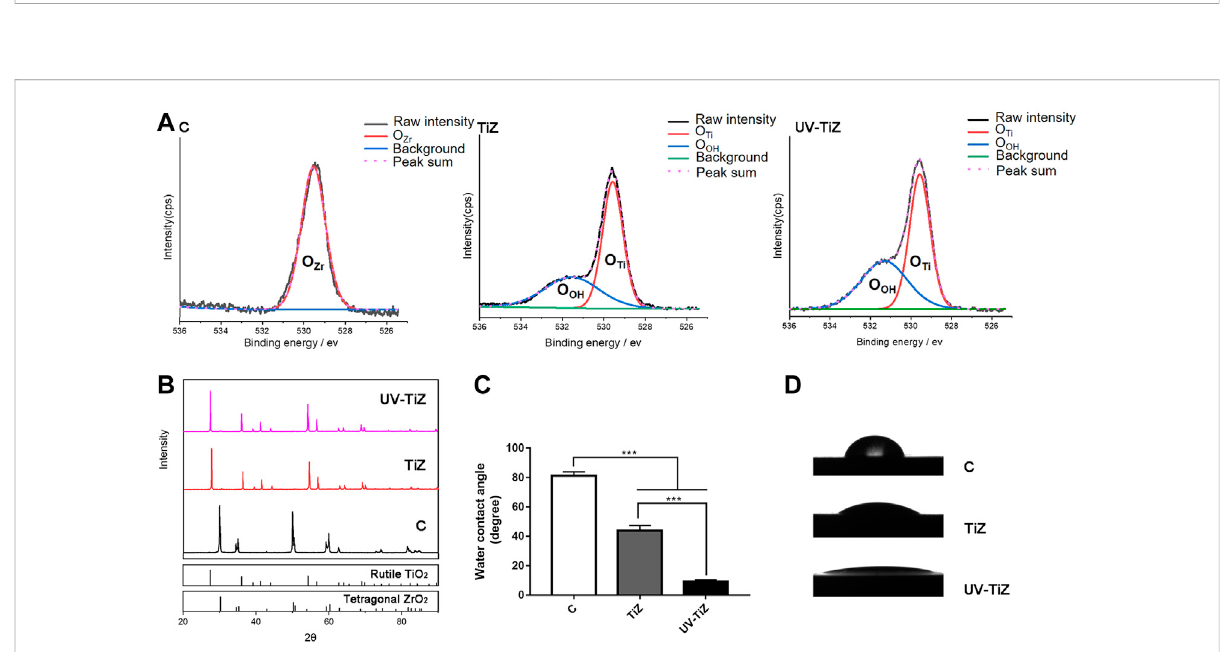
FIGURE 2 (A) Comparison ofthe XPSspectra of O1s ofthedifferenttreatmentgroups. (B) XRD patterns ofgroups C,TiZand UV-TiZ. The JCPDS numbers of different crystal phases are marked. The contact angle measurements of different specimens are exhibited in (C) and (D) . * p < 0.05, ** p < 0.01, *** p <